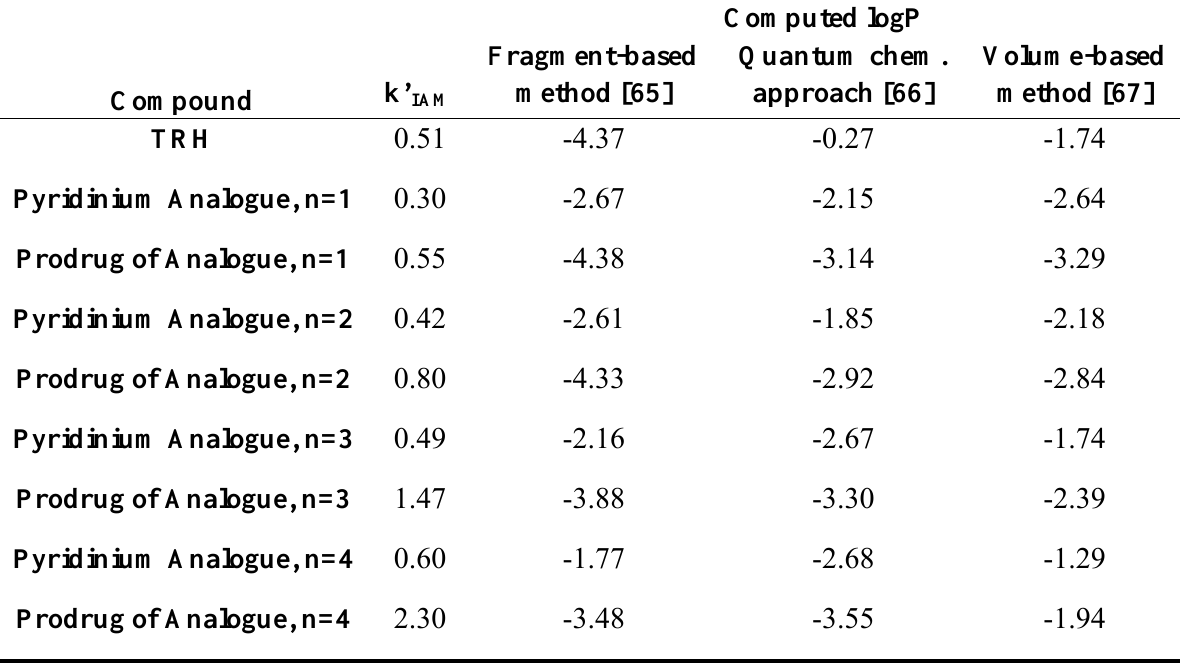
Table 3. IAMC capacity factors (k’ ) and computed logarithm of octanol/water IAM partitioning (log P) as predictors for membrane permeability for TRH, its novel analogues having pyridinium central residue and their corresponding prodrugs shown in Figure 4.